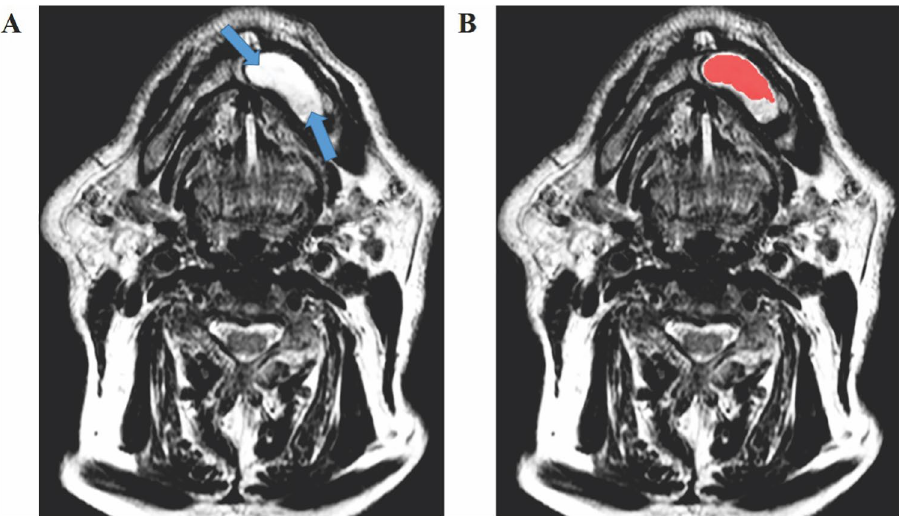
Figure 2. ( A ) Ameloblastoma with smaller volume compared to that shown in Fig. 1. However, the variable signal intensity along the entire length of the lesion is maintained, so that the most homogeneous region remains restricted to the portion characterized by the hypersignal, which is typical of T2-weighted sequences. ( B ) Segmentation process represented by the red contour. Only the most homogeneous portion of the lesion was segmented, that is, the region shown by the